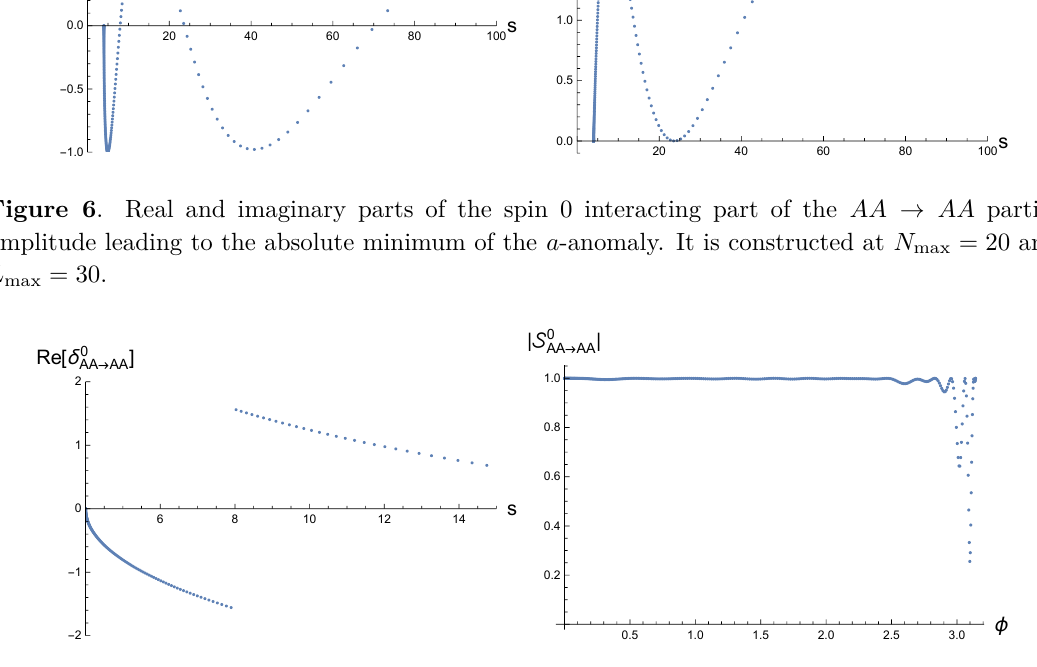
Figure 7 . An alternative representation of the amplitude given in figure 6. Left plot represents the real part of the spin 0 phase shift of the AA → AA scattering defined in (5.17). The apparent jump around s = 8 is due to the periodicity δ ' δ + π . Right plot represents the absolute value of the spin 0 partial amplitude of the AA → AA scattering. On the real axis instead of the s variable we use the φ variable defined in (G.25). The amplitude is fully “elastic” up to very high energies.